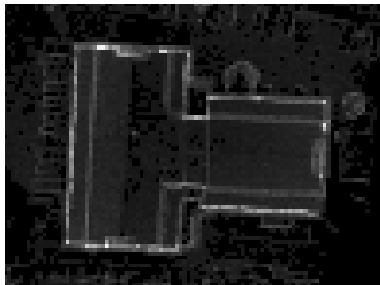
Figure 2: Projection of 3D points along the z axis on a grid for Main Building